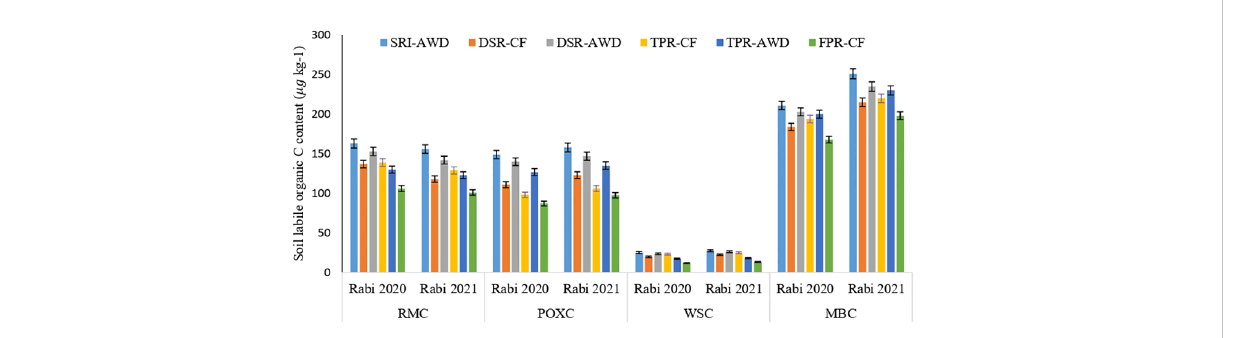
FIGURE 3 Soil labile C content such as readily mineralizable carbon (RMC), permanganate oxidizable carbon (POXC), water soluble carbohydrate carbon (WSC), and microbial biomass carbon (MBC) (g kg − 1 ) in Rabi 2020 and Rabi 2021 under different rice production techniques in rice – rice cropping